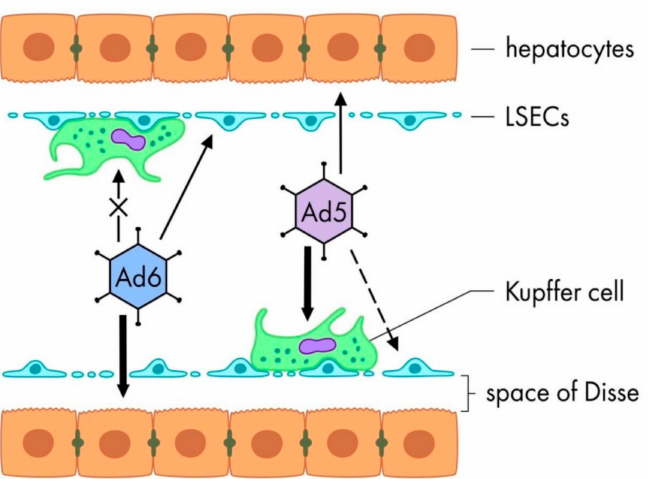
Figure 3. Difference in Ad6 and Ad5 uptake by liver scavenger cells and hepatocyte transduction after systemic delivery. Ad6 can escape Kupffer cells but can be trapped by liver sinusoidal